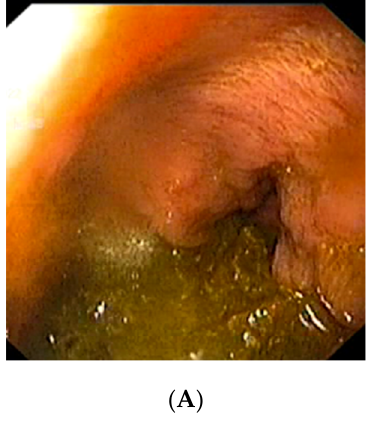
Figure 4. The upper endoscopy shows: ( A ) the stomach containing and ( B ) the extrinsic compression of the third segment of the duodenum.